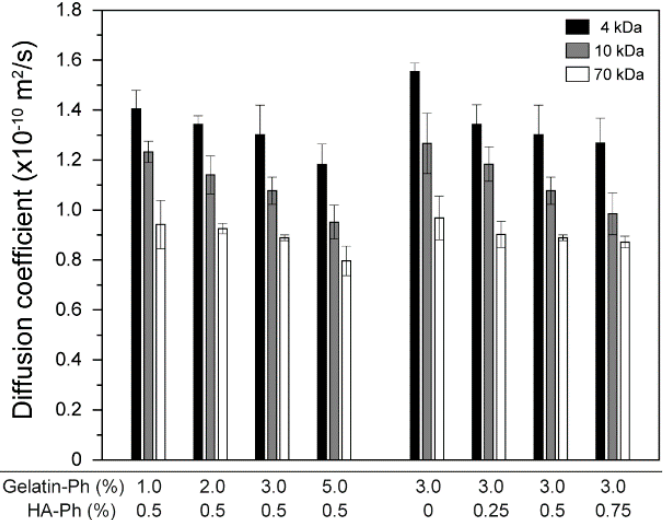
Figure 6. Effects of gelatin-Ph and HA-Ph content on diffusion coefficients of 4, 10, and 70 kDa fluorescein isothiocyanate (FITC)-labeled dextrans in hydrogels. Bars: S.D. ( n = 4).